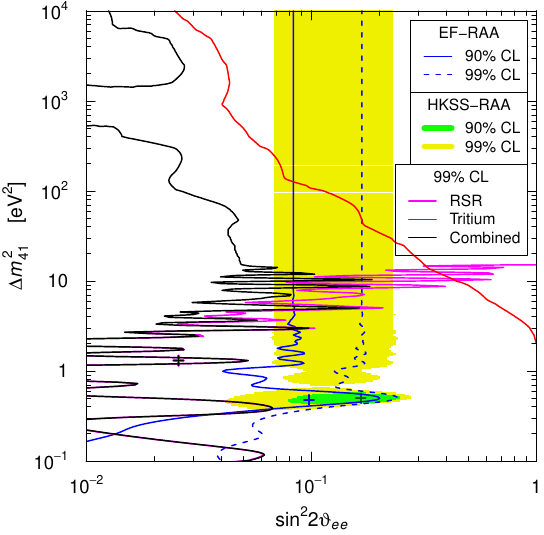
Figure 5 . 99% CL exclusion curves in the (sin 2 2 # ee ; (cid:1) m 2 ) plane obtained from the combined 41 analysis of the data of the Mainz, Troitsk and KATRIN tritium experiments and the combined analysis of the reactor spectral ratio (RSR) measurements of the Bugey-3, NEOS, PROSPECT and DANSS experiments. Also shown is the combined tritium and reactor spectral-ratio exclusion curve and the regions allowed at 90% and 99% CL by the (cid:12)ts of the absolute reactor rates assuming the Estienne, Fallot et al. [12] (EF-RAA) and the Hayen, Kostensalo, Severijns, Suhonen [13] (HKSS- RAA) reactor antineutrino (cid:13)uxes. The crosses indicate the best-(cid:12)t